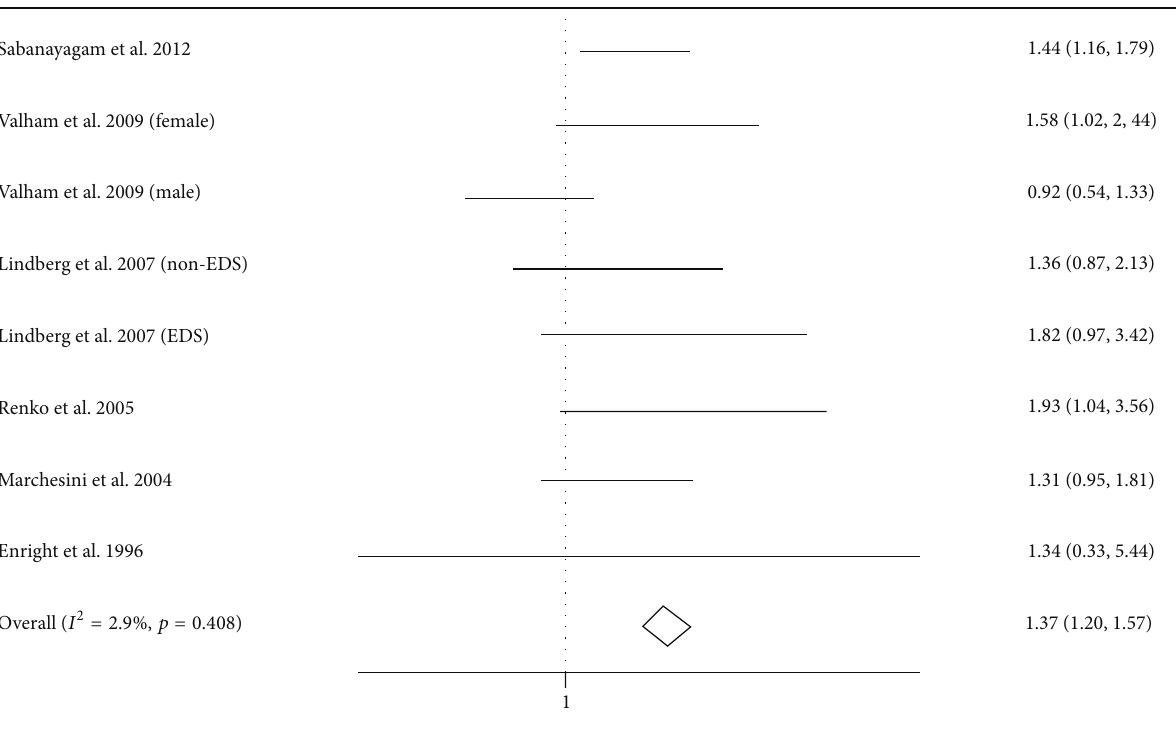
Figure 2: Forest plot of the association between self-reported habitual snoring and diabetes mellitus risk. Valham et al.’s study provided the data in female and male population not the whole population, and Lindberg et al.’s study provided the data in excessive daytime sleepiness (EDS) and non-EDS